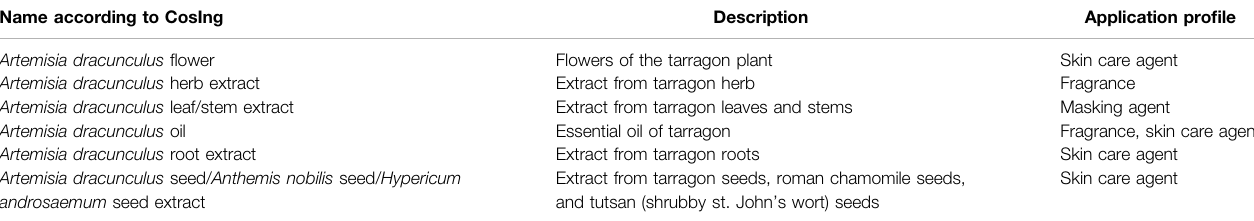
TABLE 4 | Applications of A. dracunculus in cosmetology as recommended by the CosIng database. Name according to